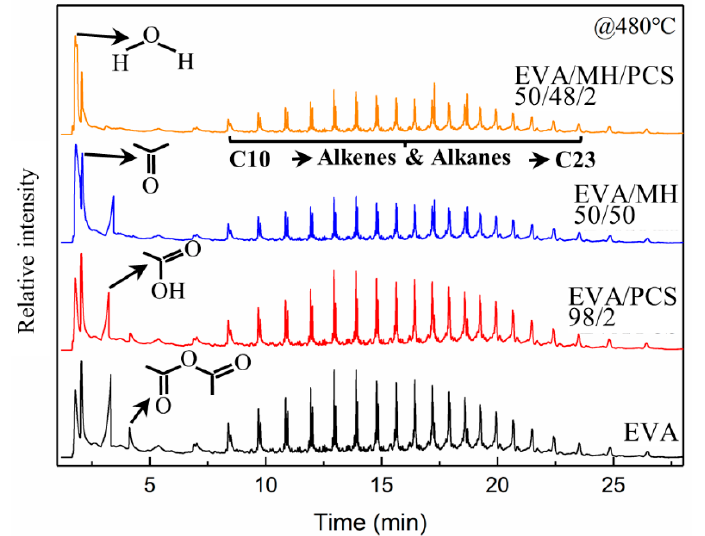
Figure 8. The pyrograms of EVA and its composites obtained from Py–GC/MS analysis at 480